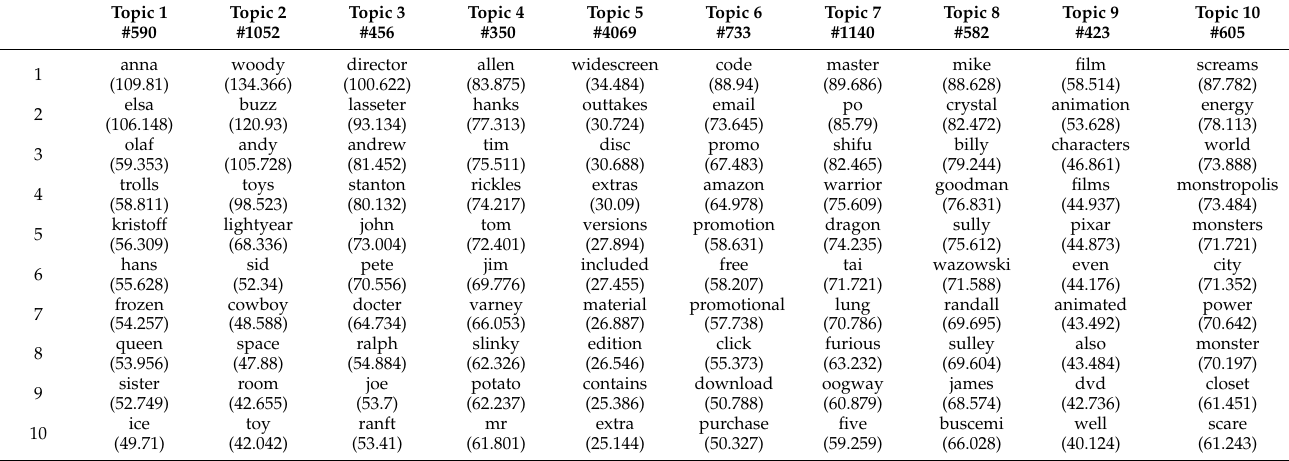
Table A18. Each column lists the top 10 representative words per dimension of the basis matrix H .